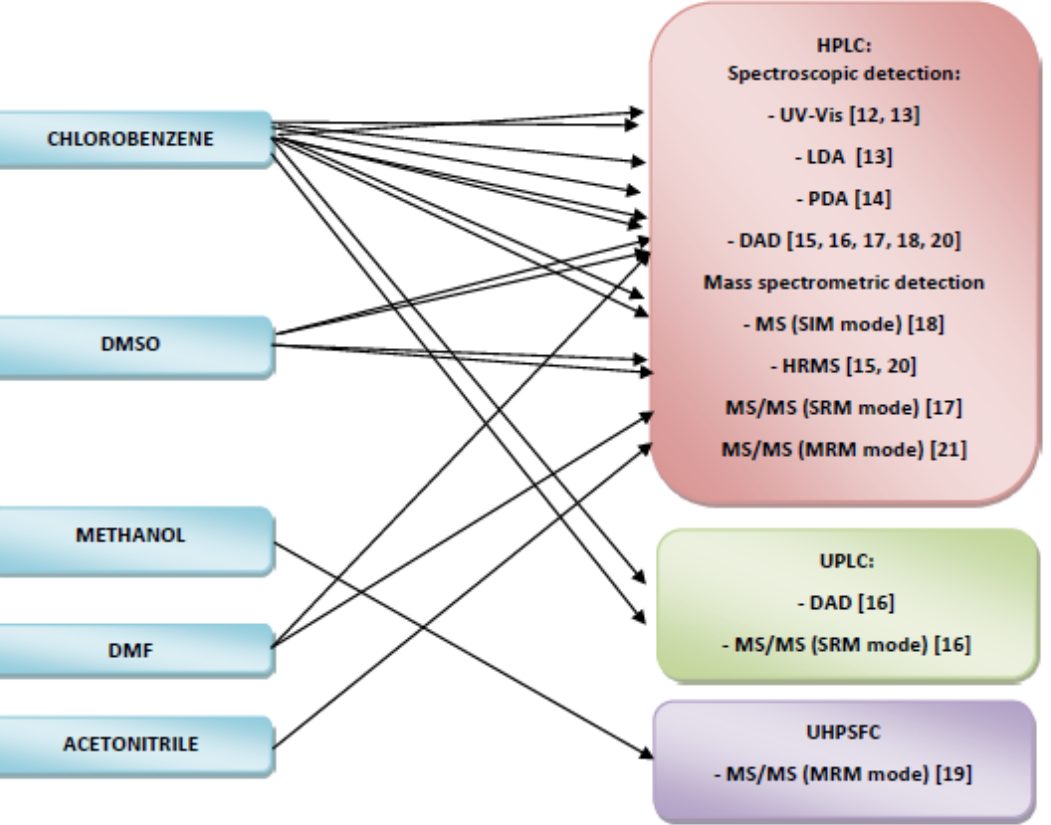
Figure 3. Chromatographic methods applied for the analysis of disperse dyes in extracts.